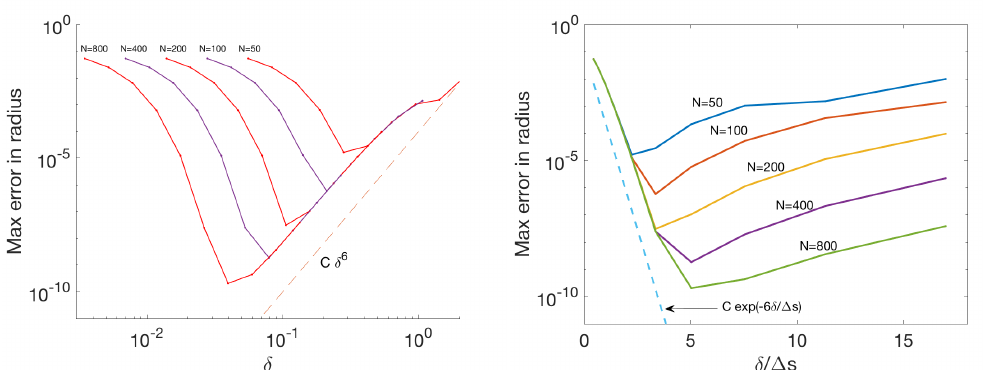
Figure 4. Errors in the circle radius in example 2 using the blob ψ δ ( r ) . The ( left ) panel shows the errors plotted versus the discretization size δ . The ( right ) panel shows the errors plotted versus δ / ∆ s